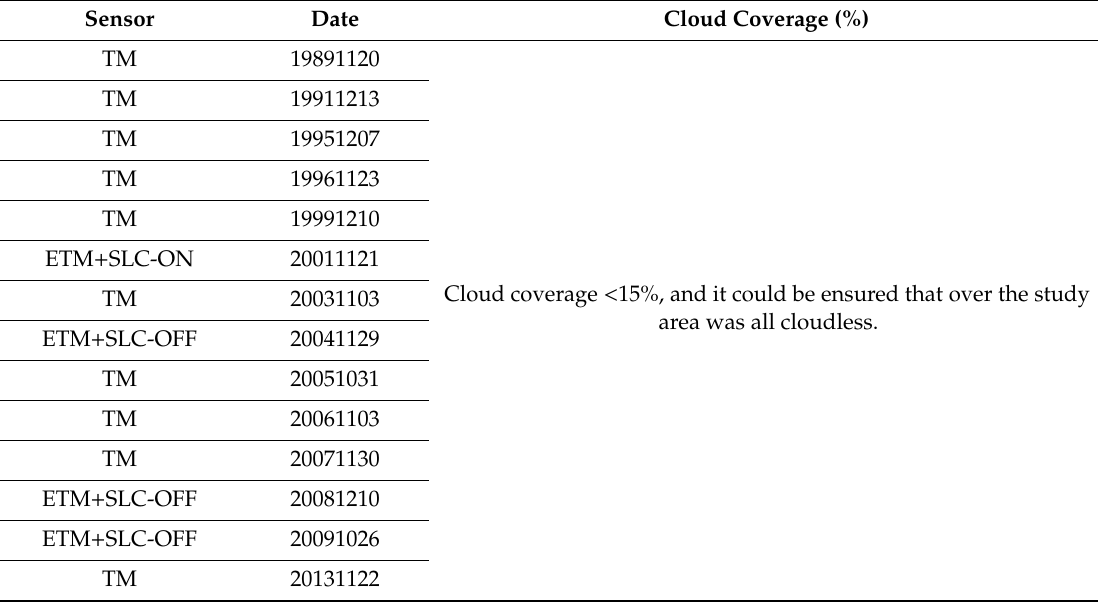
Table 1. Basic information on the remote sensing images of Poyang Lake, China.